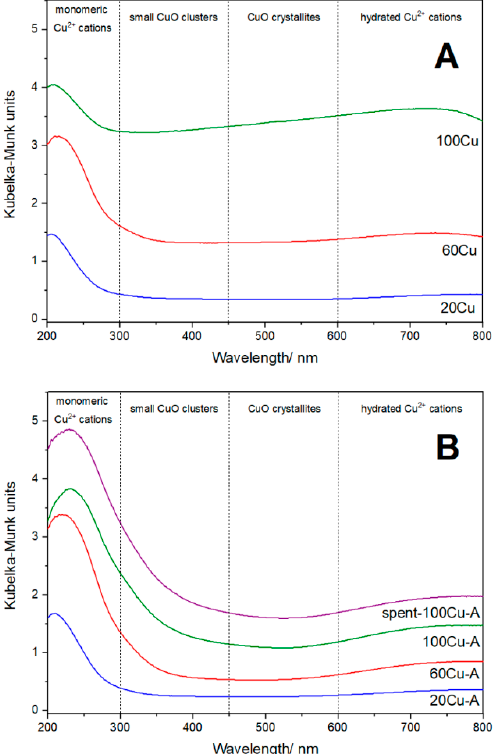
Figure 7. UV-vis-DR spectra of the Al-S-MCM-41 sample modified with copper by TIE ( A ) and TIE-NH 3 ( B ) methods.